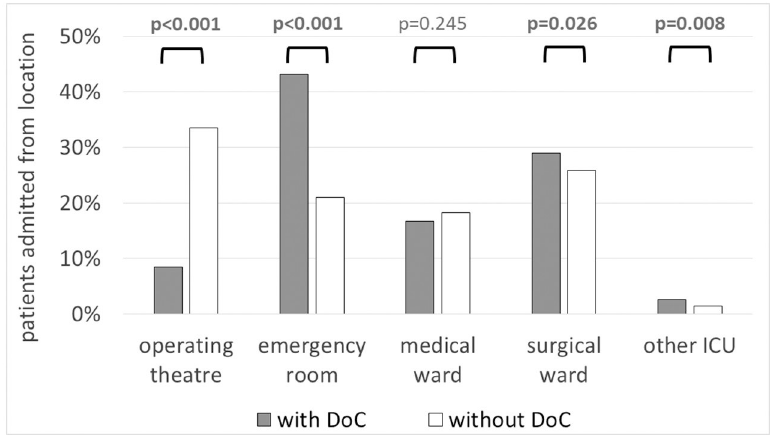
Fig 2. Sources of ICU admission among patients discharged from the ICU with and without DoC.